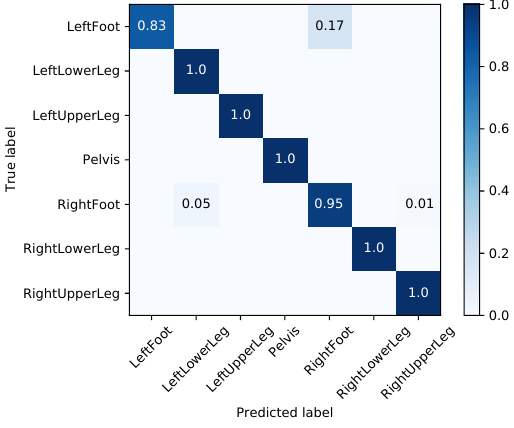
Figure A6. I2S assignment problem, final model: test person from dataset B , IMU configuration 5 (cf. Table A7). Average accuracy: 97.29%.